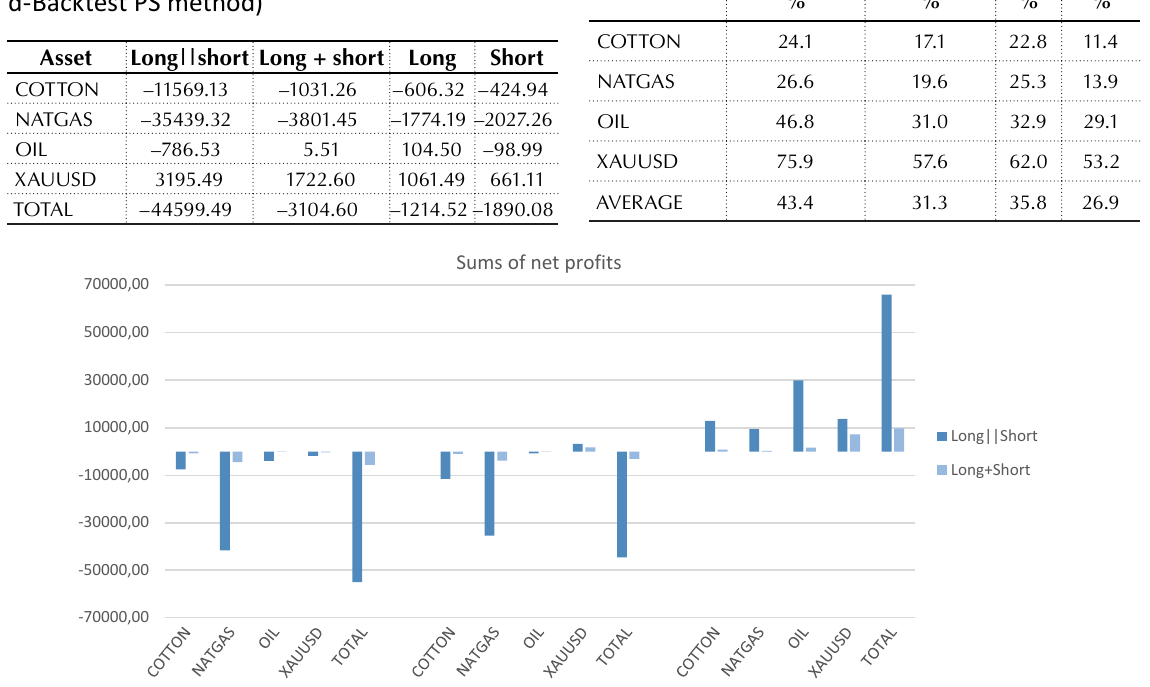
Figure 8. Sums of profits using three different parameter setting